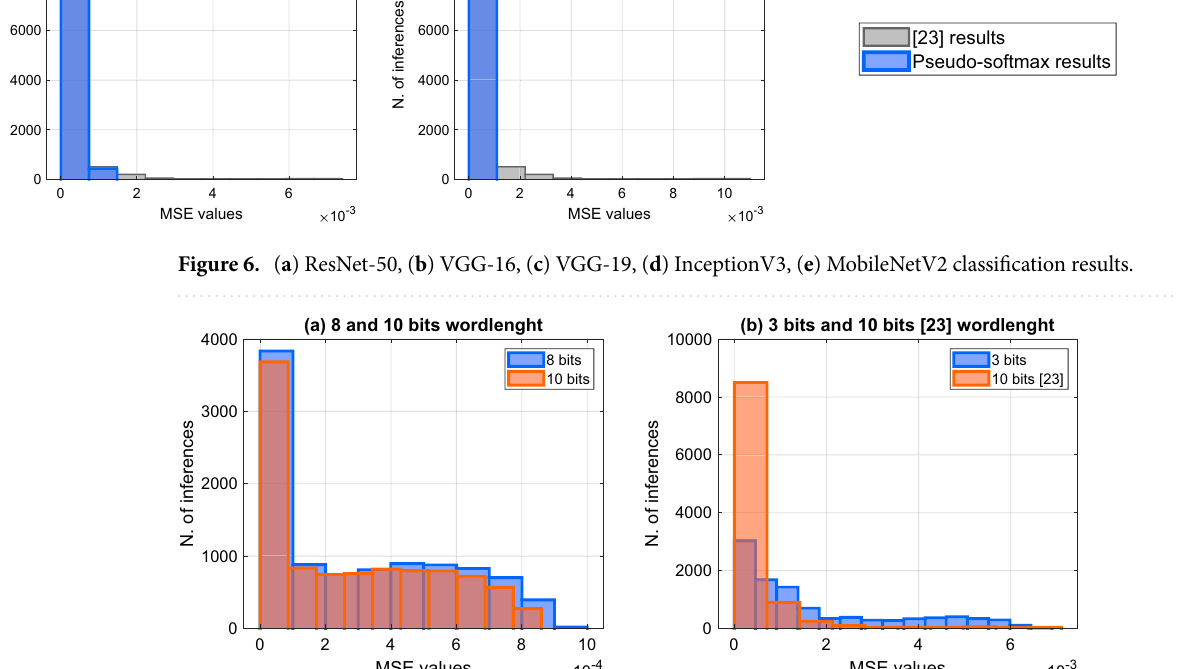
Figure 7. VGG-16 classification results for different quantizations: ( a ) 8 bits and 10 bits, ( b ) 3 bits and 10 bits of 23